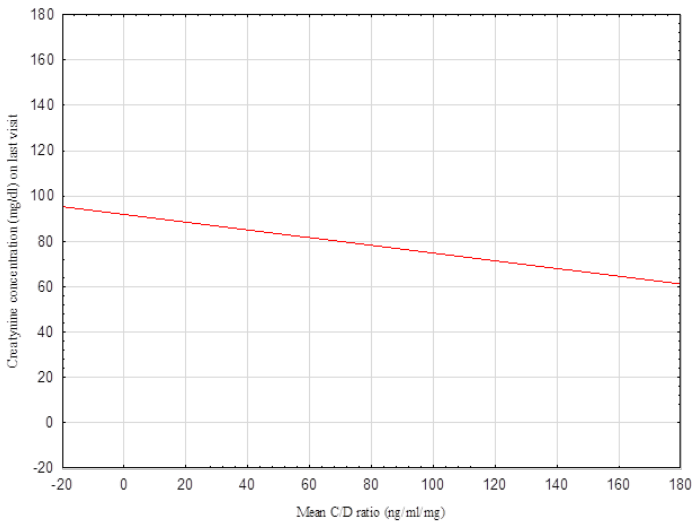
Figure 2. Correlation between the mean C/D ratio and the creatinine concentration from the last appointment. Using Spearman’s rank correlation test, a negative correlation was identified between the mean C/D ratio and the creatinine concentration from the last appointment: p < 0.05 R − 0.1.